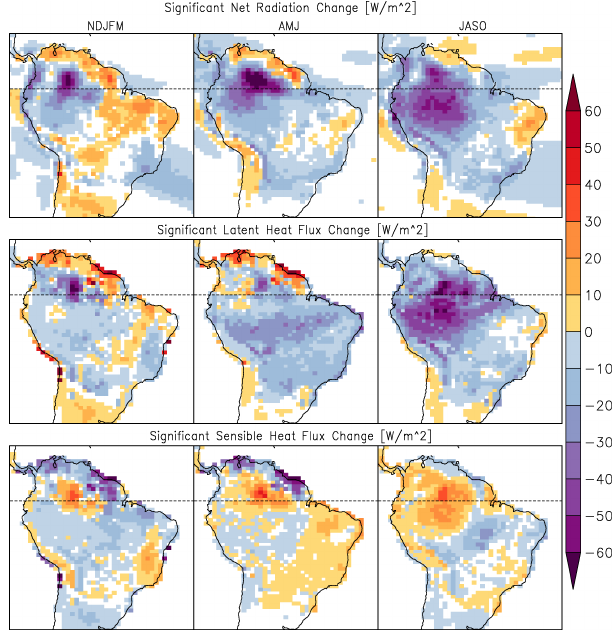
Figure 6. Changes in surface energy fluxes in NDJFM, AMJ and JASO; net radiation (Wm − 2 ) (top row), latent heat flux (Wm − 2 ) (middle row) and sensible heat flux (Wm − 2 ) (bottom row). Shading indicates significance at the 95% confidence